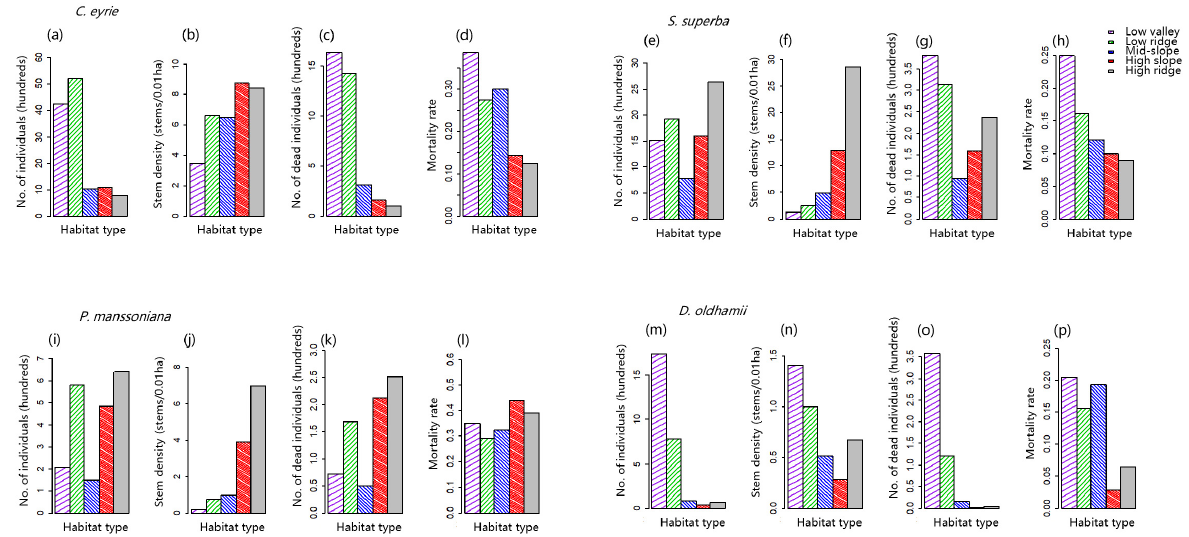
Figure 3. Distributions of dead individuals for each canopy dominant species in five habitats . ( a – d ) Abundance, density, deaths, and mortality rate of C. eyrei in five habitats; ( e – h ) abundance, density, deaths, and mortality rate of S. superba in five habitats; ( i – l ) abundance, density, deaths, and mor- tality rate of P. massoniana in five habitats; ( m – p ) abundance, density, deaths, and mortality rate of D. oldhamii in five habitats.